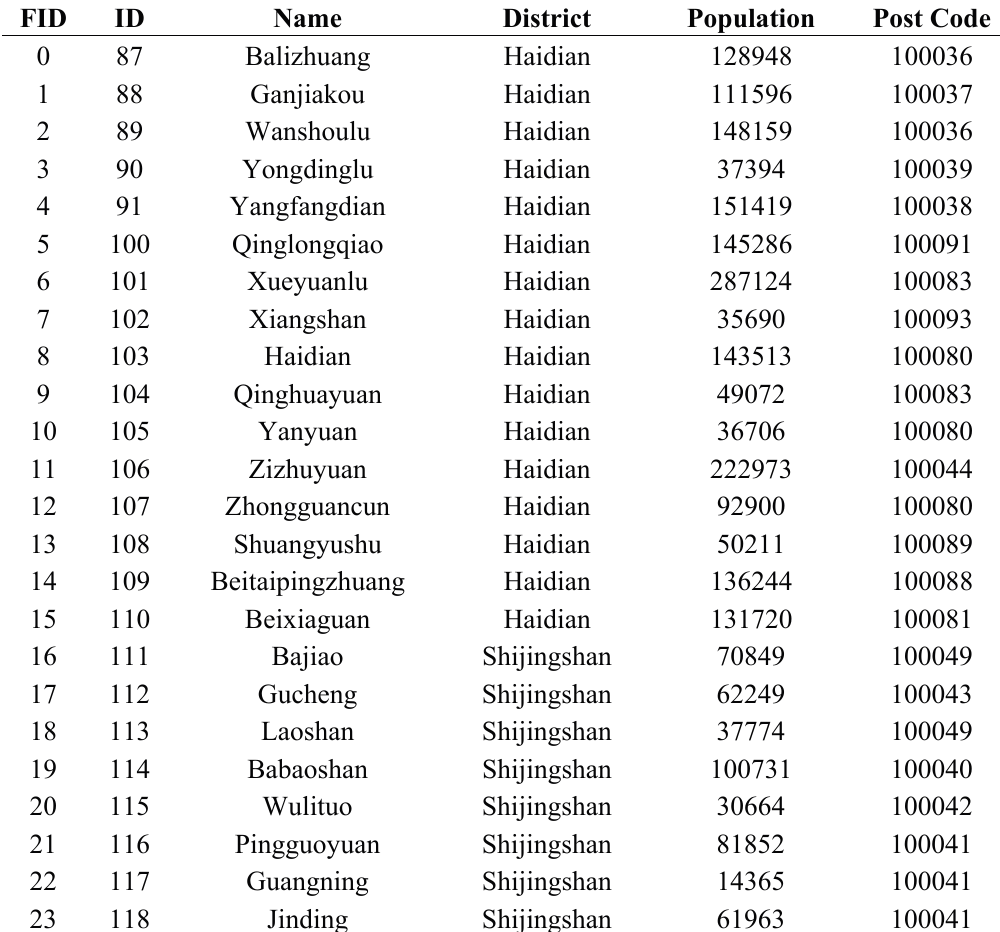
Table 1. Districts in the study